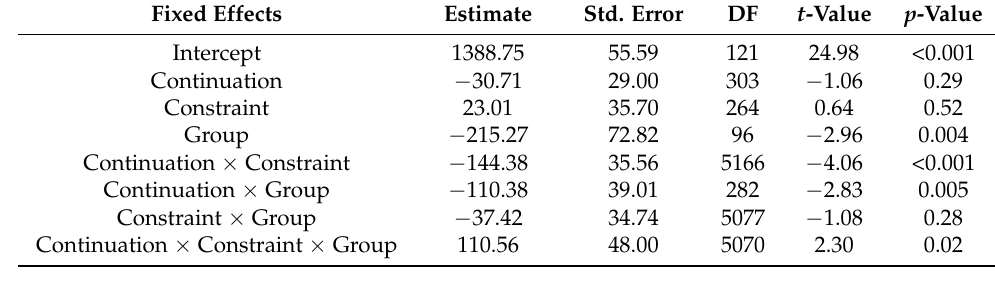
Table 3. Results of the Linear Mixed Effects Model.